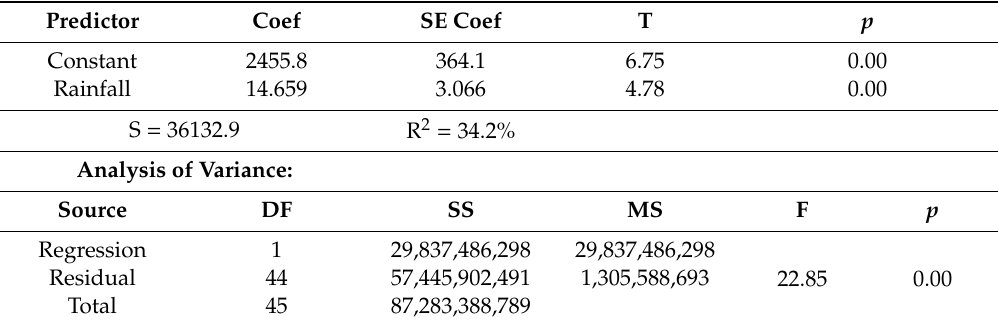
Table 3. Monthly ordinary linear regression analysis of dengue versus